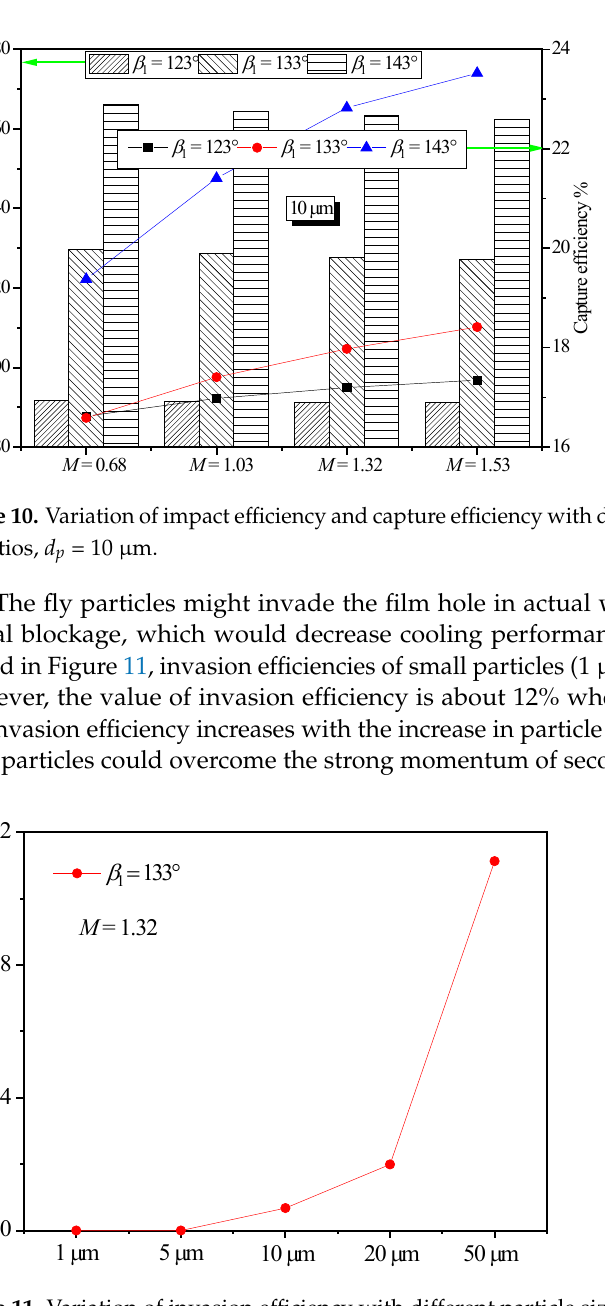
Figure 11. Variation of invasion efficiency with different particle sizes ( M = 1.32, β 1 = 133°).